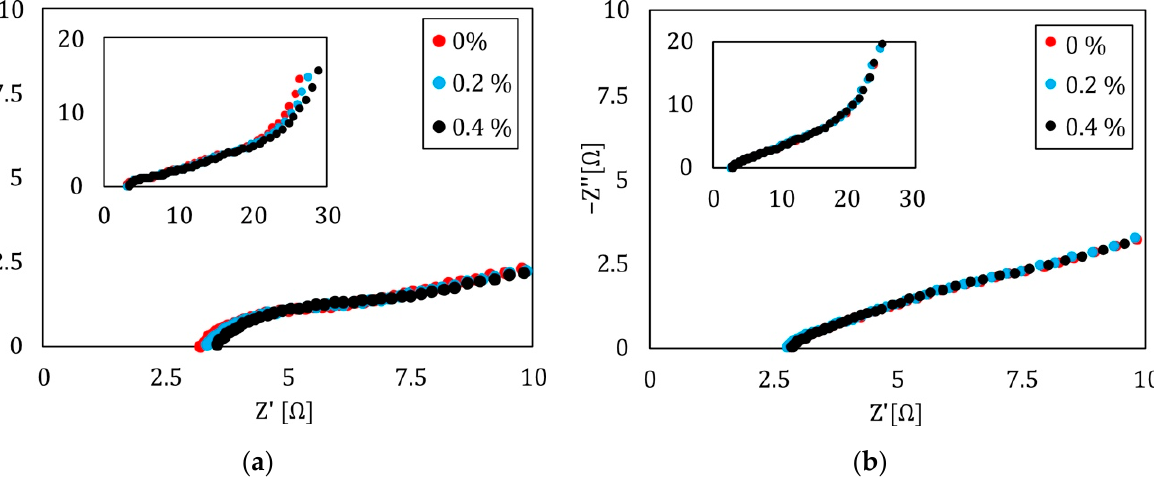
Figure 7. Influence of mechanical force on a structurally integrated energy storage ( a ) EIS plot for three different load situations. Red indicates a load free situation, while blue and black show the EIS results under mechanical load with 0.2% and 0.4% strain. All measurements are performed in a 4PB experiment on the tension side of the sample. Frequency range was 100 mHz–1 MHz. ( b ) EIS plot for three different load situations. Red indicates a load free situation, while blue and black show the EIS results under mechanical load with 0.2% and 0.4% strain. All measurements are performed in a 4PB experiment on the compression side of the sample. Impedance is visualized by rectangles, the phase by circles.